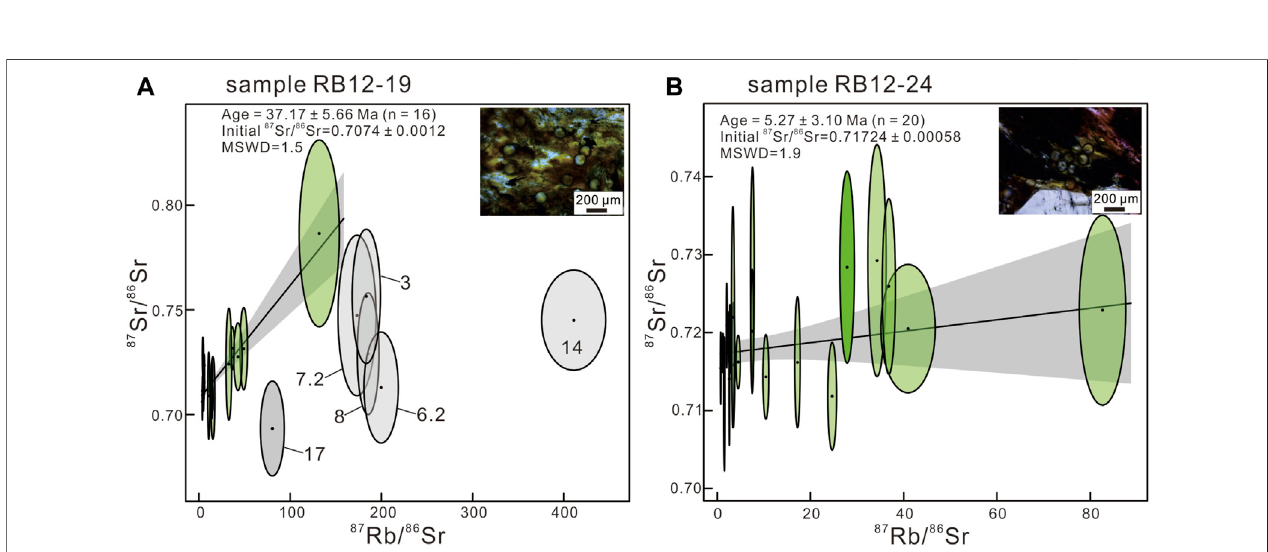
FIGURE 9 | In situ LA – ICP – MS biotite Rb – Sr isochron diagrams and photos of biotite with the laser spot: (A) sample RB12-19 and (B) sample RB12-24.